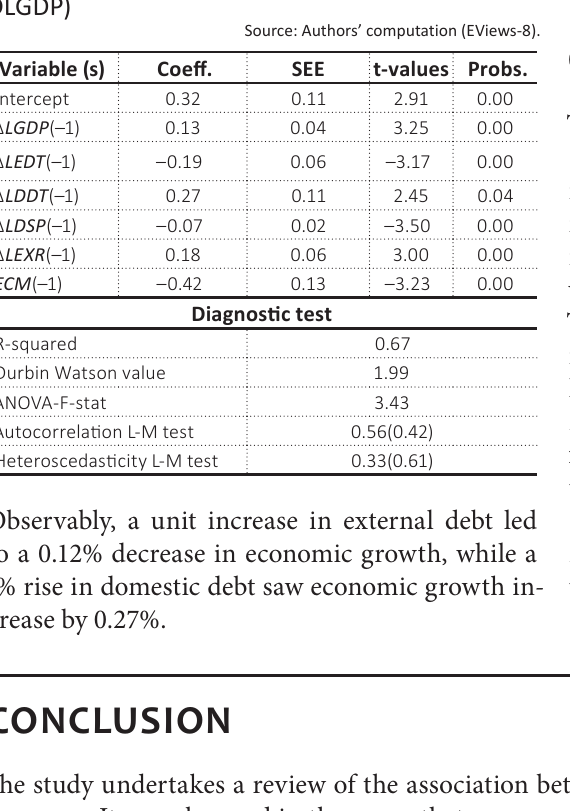
Table 5. Estimated ECM (dependent variable: